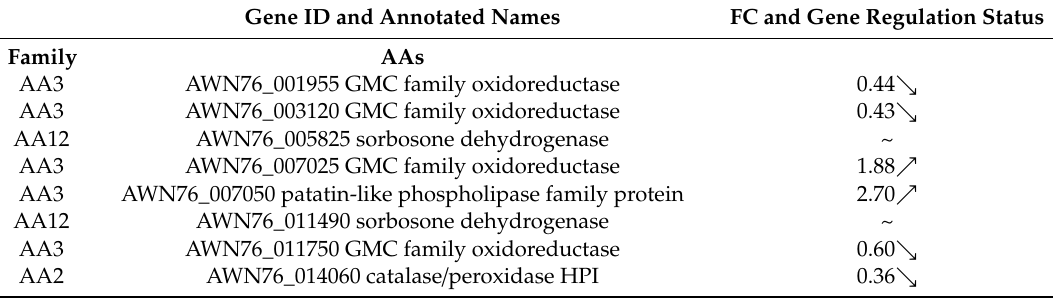
Table 6. Fold change of putative auxiliary activities enzymes (AAs) in strain RA. Gene ID and Annotated